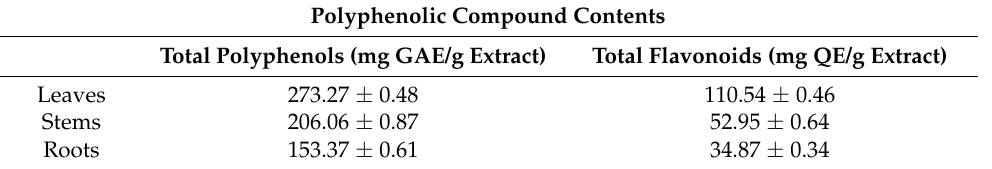
Table 2. Polyphenolic compound assay results. GAE: gallic acid equivalents, QE: quercetin equiva- lents (mean ± standard deviation of three independent